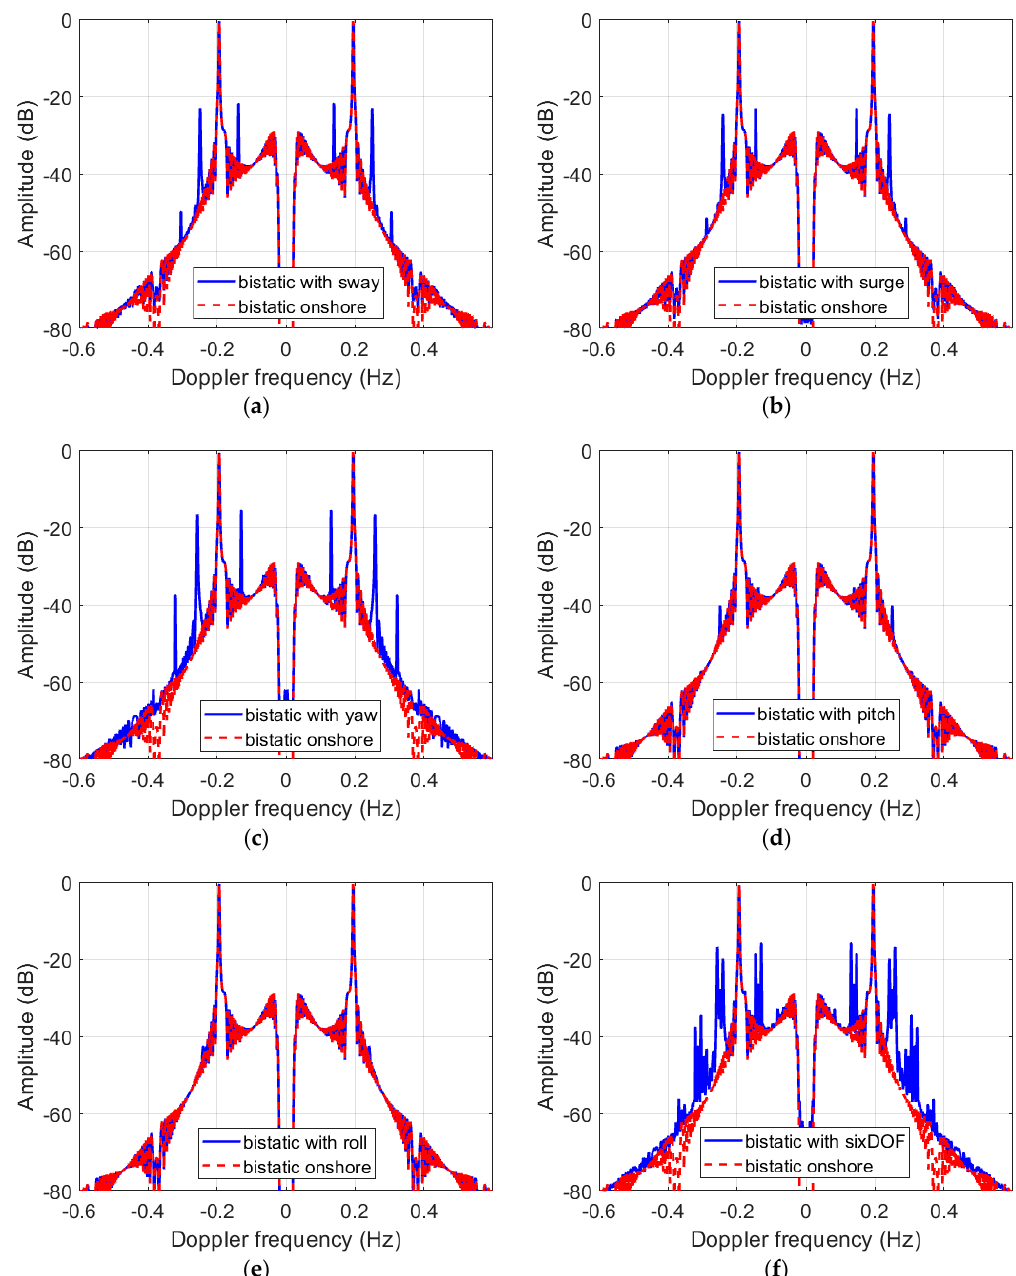
Figure 7. Simulated first-order RCSs for di ff erent motions. ( a ) Sway case; ( b ) surge case; ( c ) yaw case; ( d ) pitch case; ( e ) roll case; ( f ) six DOF